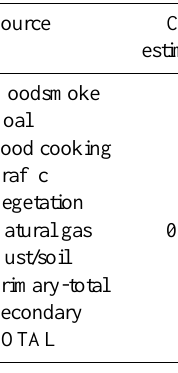
Table 6. Comparison of apportionment of organic matter by the AMS-PMF and CMB method at NK (µgm − 3